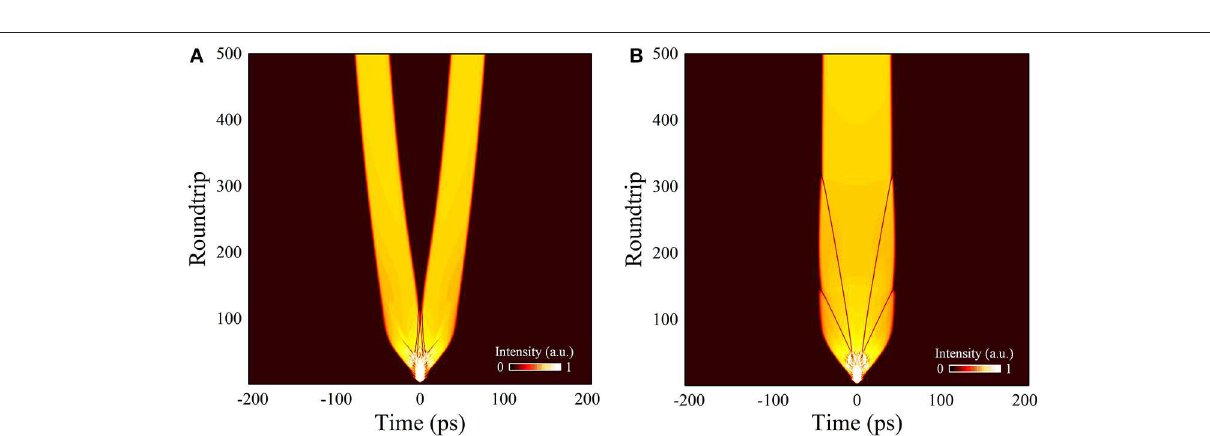
have straight trajectories). This make the dark solitons possible to avoid decaying at the wings of the background pulse. Here, as shown in Figure 3A , although 2 gray solitons decay in the background, 4 dark solitons move straight toward the center of the background DSR pulse, and after collisions they finally converge into one big intensity dip when the roundtrip